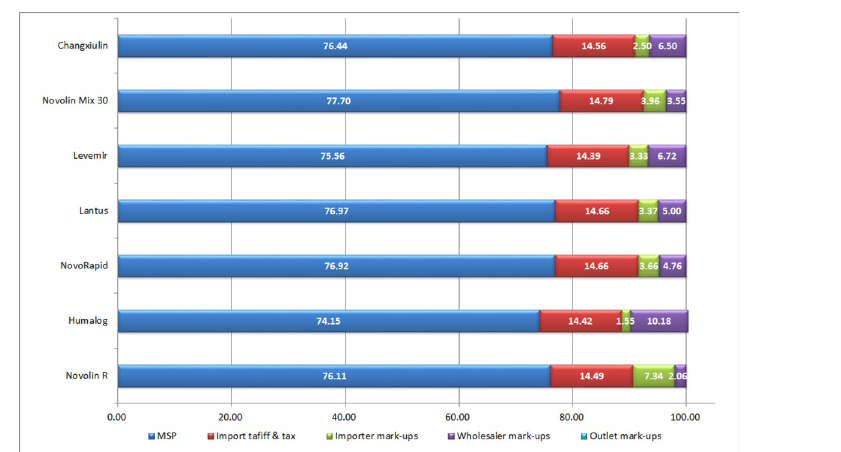
Fig 1. Insulin price components before the implementation of the bidding policy.